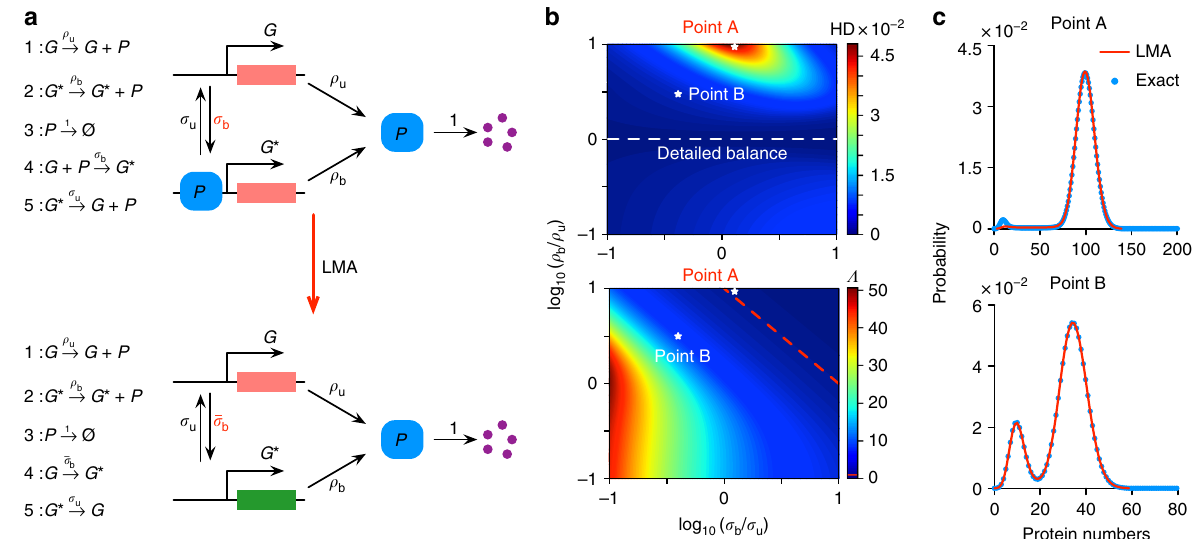
Fig. 1 Linear mapping approximation (LMA) and its application to steady-state conditions. a Illustration of the main idea behind the LMA namely to approximate the reversible (nonlinear) reaction between protein and promoter in the nonlinear GRN by a fi rst-order (linear) reaction with an effective reaction rate in a linear GRN. b The upper fi gure shows a heatmap of Hellinger distance (HD) between the LMA and the exact probability distribution of protein numbers in steady-state conditions with parameters ρ u = 10, σ u = 0.01 for the nonlinear GRN shown in a . The exact distribution is reported in 7 . The bottom fi gure shows a heatmap of Λ , which is the ratio of the values of the two eigenvalues of the Jacobian of the deterministic rate equations of the nonlinear GRN in steady-state conditions. The red broken line denotes the contour line of Λ = 1. Note that the value of the HD is very small over a wide range of the ratio of time scales Λ indicating that the LMA ’ s accuracy is independent of time-scale separation. c A comparison of the LMA and exact steady-state distributions for Points A and Point B, marked as white stars, on the heatmap in b ; note that Point A corresponds to the parameter set with the largest HD ( ρ b = 100, σ b = 0.0126 with HD of 0.0478). Point B corresponds to ρ b = 35, σ b = 0.004 with HD of